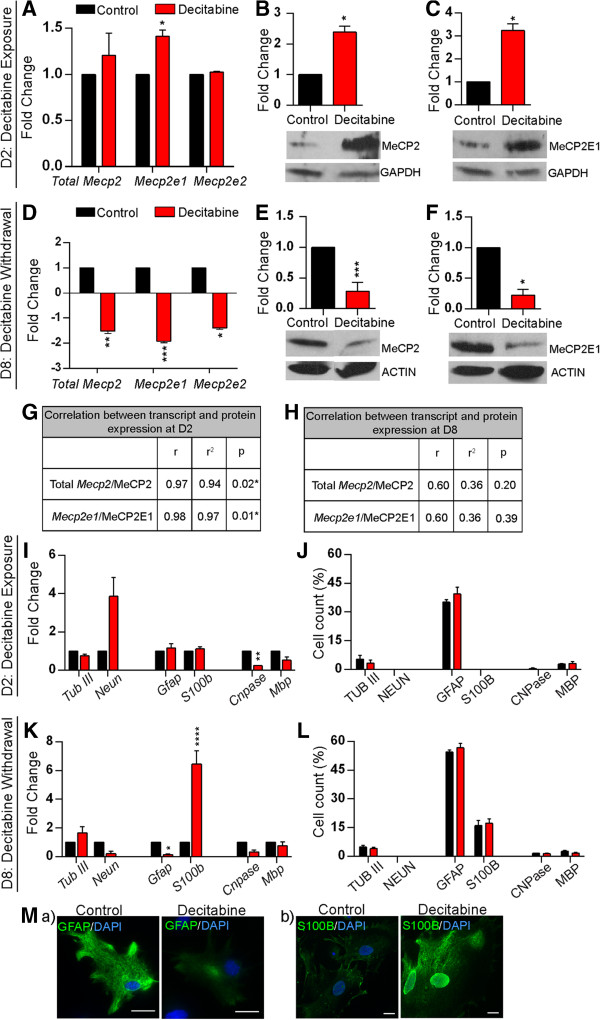
Effect of decitabine exposure and withdrawal on Methyl CpG binding protein gene (Mecp2/MeCP2) expression. (A-C), After exposure to decitabine at D2. (A) Analysis of Mecp2 (total), Mecp2e1 and Mecp2e2 transcript levels by qRT-PCR. (B) Detection of MeCP2 (total) protein expression levels by western blot; n = 2 ± standard error of the mean (SEM). (C) Detection of MeCP2E1 protein expression levels by western blot; n = 2 ± SEM. (D-F), After withdrawal of decitabine at day 8 (D8). (D) Analysis of total Mecp2, Mecp2e1 and Mecp2e2 transcript levels by qRT-PCR. (E) Detection of MeCP2 (total) protein expression levels by western blot. (F) Detection of MeCP2E1 protein expression levels by western blot. (G-H) Pearson's correlation analysis of the relation between Mecp2 transcript levels and MeCP2 protein levels at D2 (G) and D8 (H); r = Pearson’s correlation coefficient, r2 = coefficient of determination. (I) Transcript detection of cell type-specific markers for neurons (Tub III, NeuN); astrocytes (Gfap, S100b); oligodendrocytes (Cnpase, Mbp) by qRT-PCR in D2 control and decitabine-treated cells. (J) Quantification of neurons, astrocytes and oligodendrocytes using cell type-specific markers by immunofluorescence in D2 control and decitabine-treated cells. (K) Transcript detection of cell type-specific markers for neurons (Tub III, NeuN); astrocytes (Gfap, S100b); oligodendrocytes (Cnpase, Mbp) by qRT-PCR in D8 control and decitabine-treated cells. (L) Quantification of neurons, astrocytes and oligodendrocytes using cell type-specific markers in D8 control and decitabine-treated cells. (M) Comparison of immunofluorescent detection of (a) Glial fibrillary acidic protein (GFAP) and (b) S100B between control and decitabine-treated cells. Images were taken at the same exposure time. Scale bars represent 20 μm. For all the panels, fold changes are calculated relative to expression levels at D2 or D8 controls. Significant differences from controls: ****P <0.0001; ***P <0.001; **P <0.01; *P <0.05, n = 3 ± SEM, unless specifically mentioned.